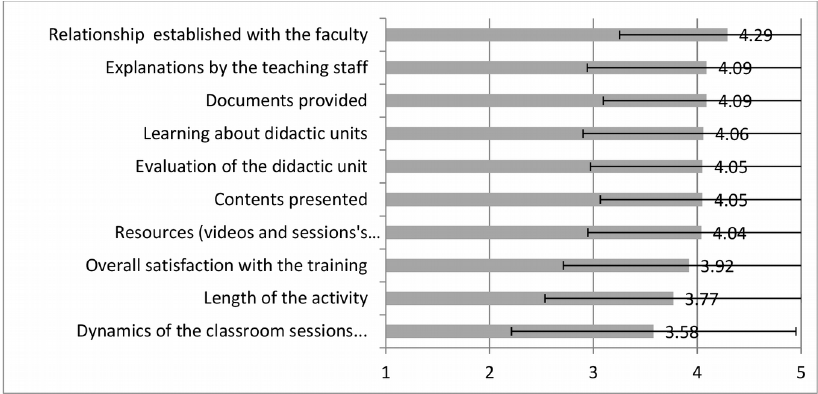
Figure 1. Student satisfaction with the training received (scale of 1 to 5)